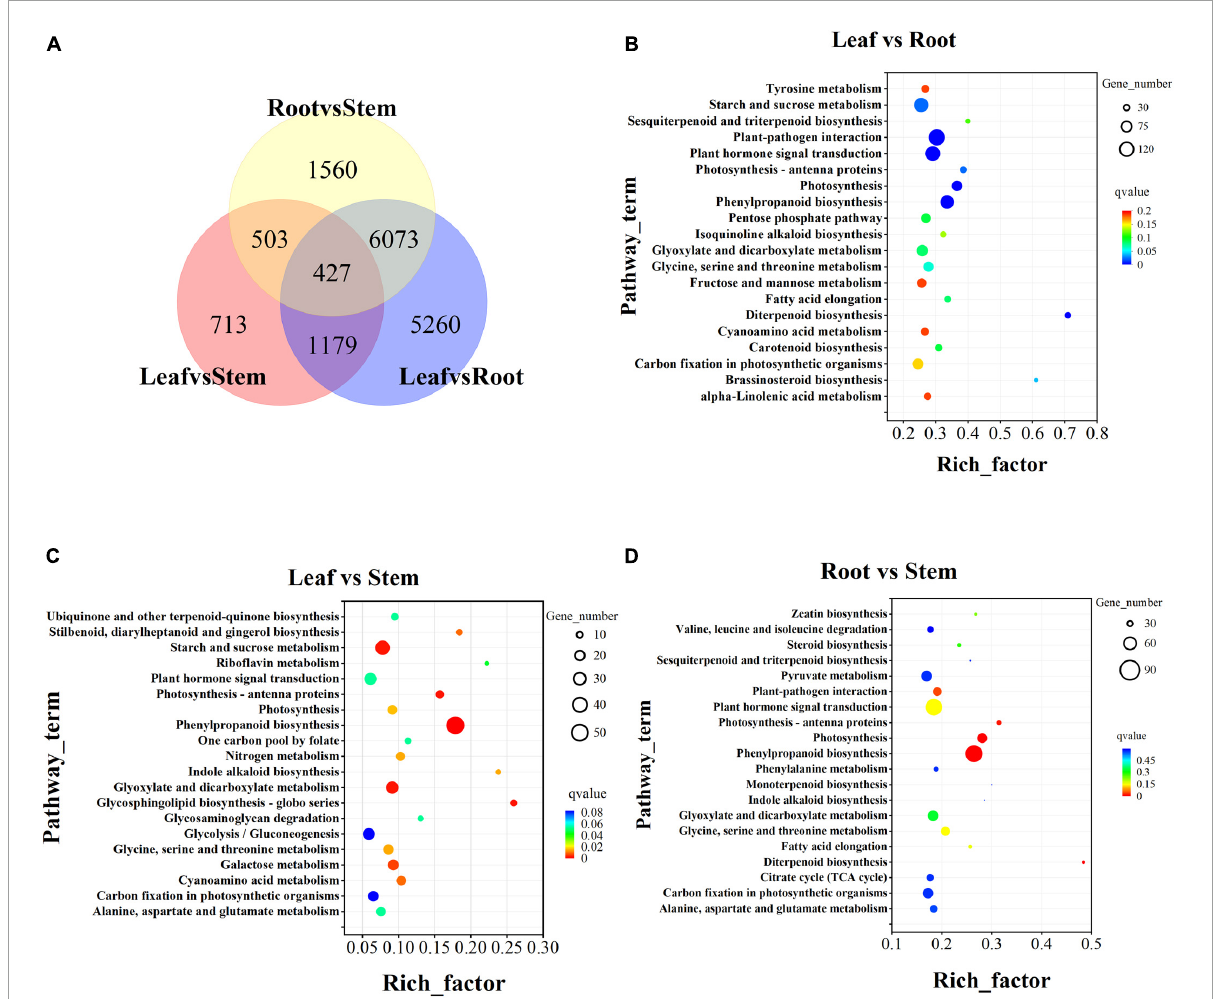
FIGURE6 Transcriptome difference analysis. (A) Differential venn diagram of three tissues and differential venn diagram between groups. (B) Top 20 of KEGG pathway enrichment of Leaf vs. Root DEGs. (C) Top 20 of KEGG pathway enrichment of Leaf vs. Stem DEGs. (D) Top 20 of KEGG pathway enrichment of Root vs. Stem DEGs. The screening criteria for DEGs are p < 0.05 and | log 2 FoldChange| > 1 by